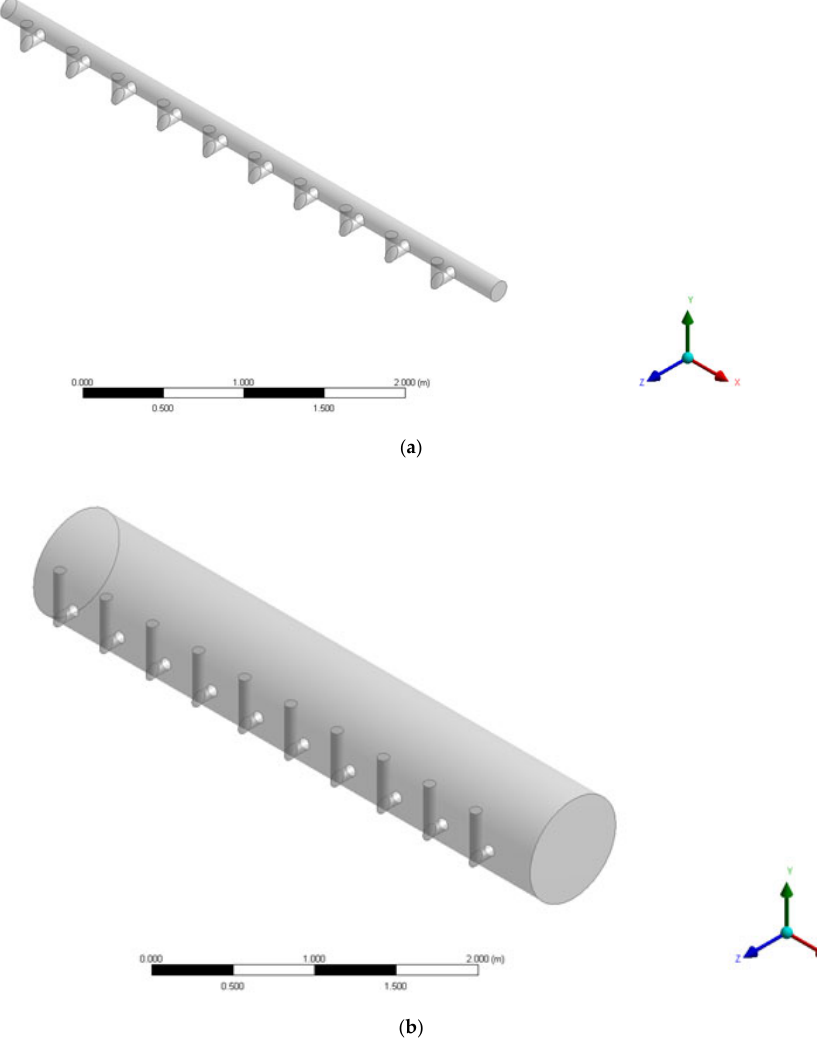
Figure 4. Geometry of manifold pipes: ( a ) Actual manifold pipe ( Σ a/A=3.265, a: branch pipe cross- sectional area, A: header pipe cross-sectional area) and ( b ) Manifold- pipe with an enlarged diameter ( a/A = 0.116).